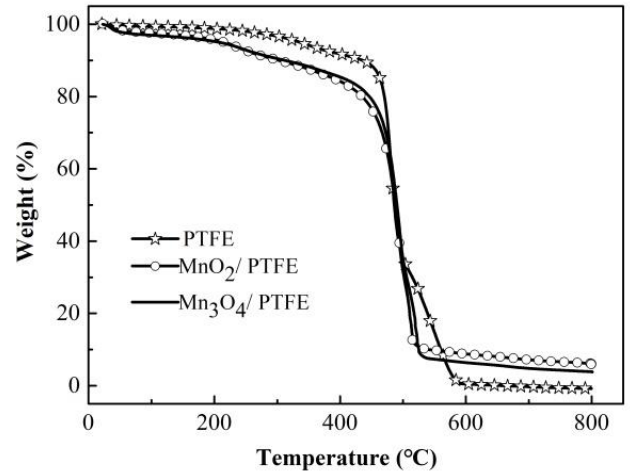
Figure 7. TG analysis of PTFE, MnO 2 /PTFE, and Mn 3 O 4 /PTFE HFMs.